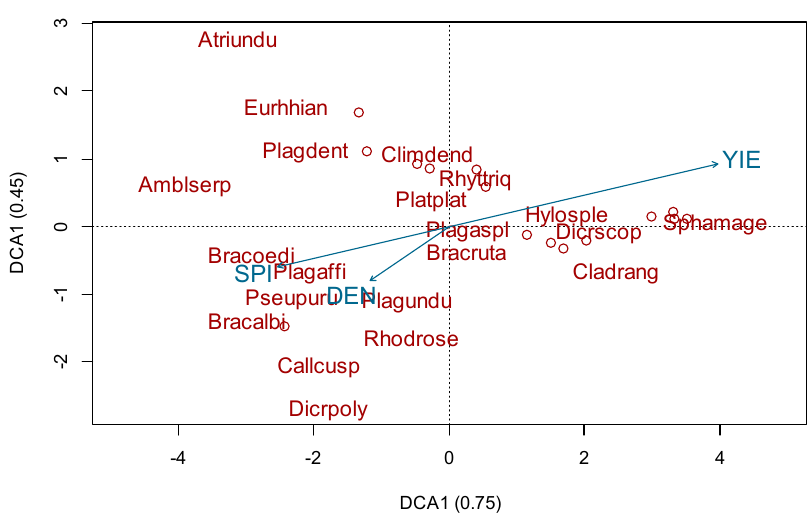
Figure 4. Grouping of moss species: results of detrended correspondence analysis. Analyzed factors: density (DEN), stream power index (SPI), total yeld (YIE).